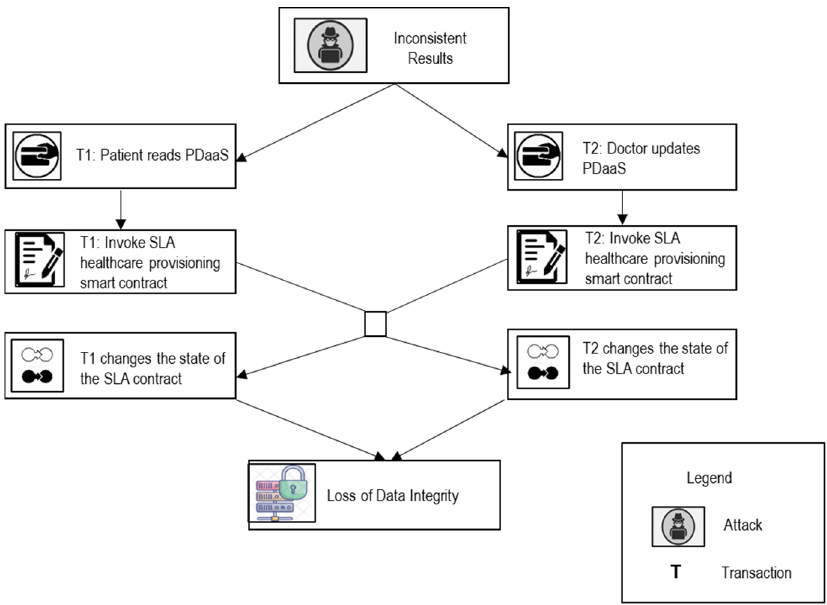
Figure 7. Threat Model for transaction ordering dependence scenario 1: Loss of data integrity.